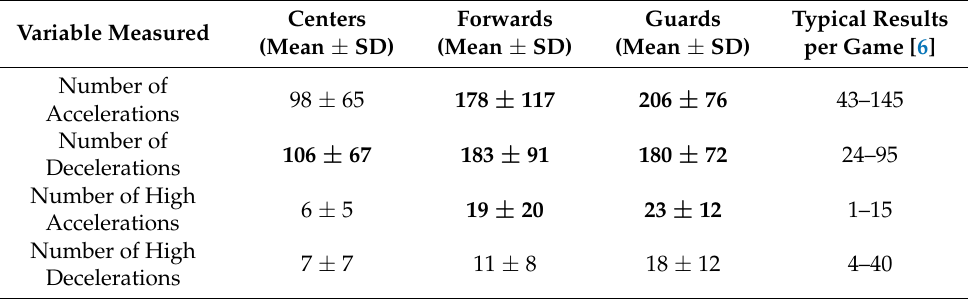
Table 5. Comparison of acceleration and deceleration count variables measured during game sessions from presented dataset to other datasets found in the literature [6]. Measurements under playing positions in which the mean was higher than the maximum value of typical results are in bold. Centers Forwards Typical Variable Measured (Mean ± SD) (Mean ± SD) (Mean ± SD)